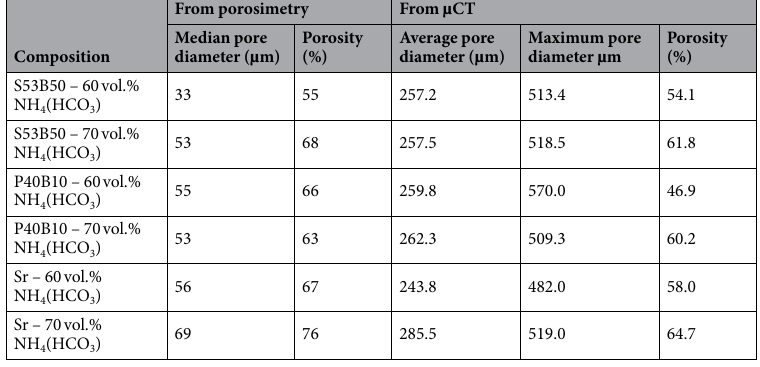
Table 4. Composition, Average pore diameter and % Porosity of